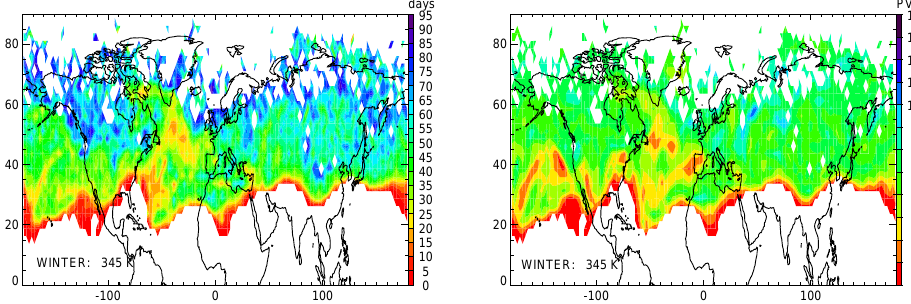
Fig. 2. Distribution of t TST on the Θ = 345 K isentrope for trajectories initialized in the LMS at 00:00 UTC, on 1 February 2008 (left), and PV distribution at the same time (right). White areas at mid and high latitudes denote regions where no crossing trajectories are found. The tropopause (2PVU) corresponds to t TST = 0 at latitudes < 40 ◦ N. White areas south of 40 ◦ N are tropospheric where no trajectories were initialized. The gradient from red to blue indicates increasing t TST (left) as well as increasing PV (right) with distance from the tropopause.